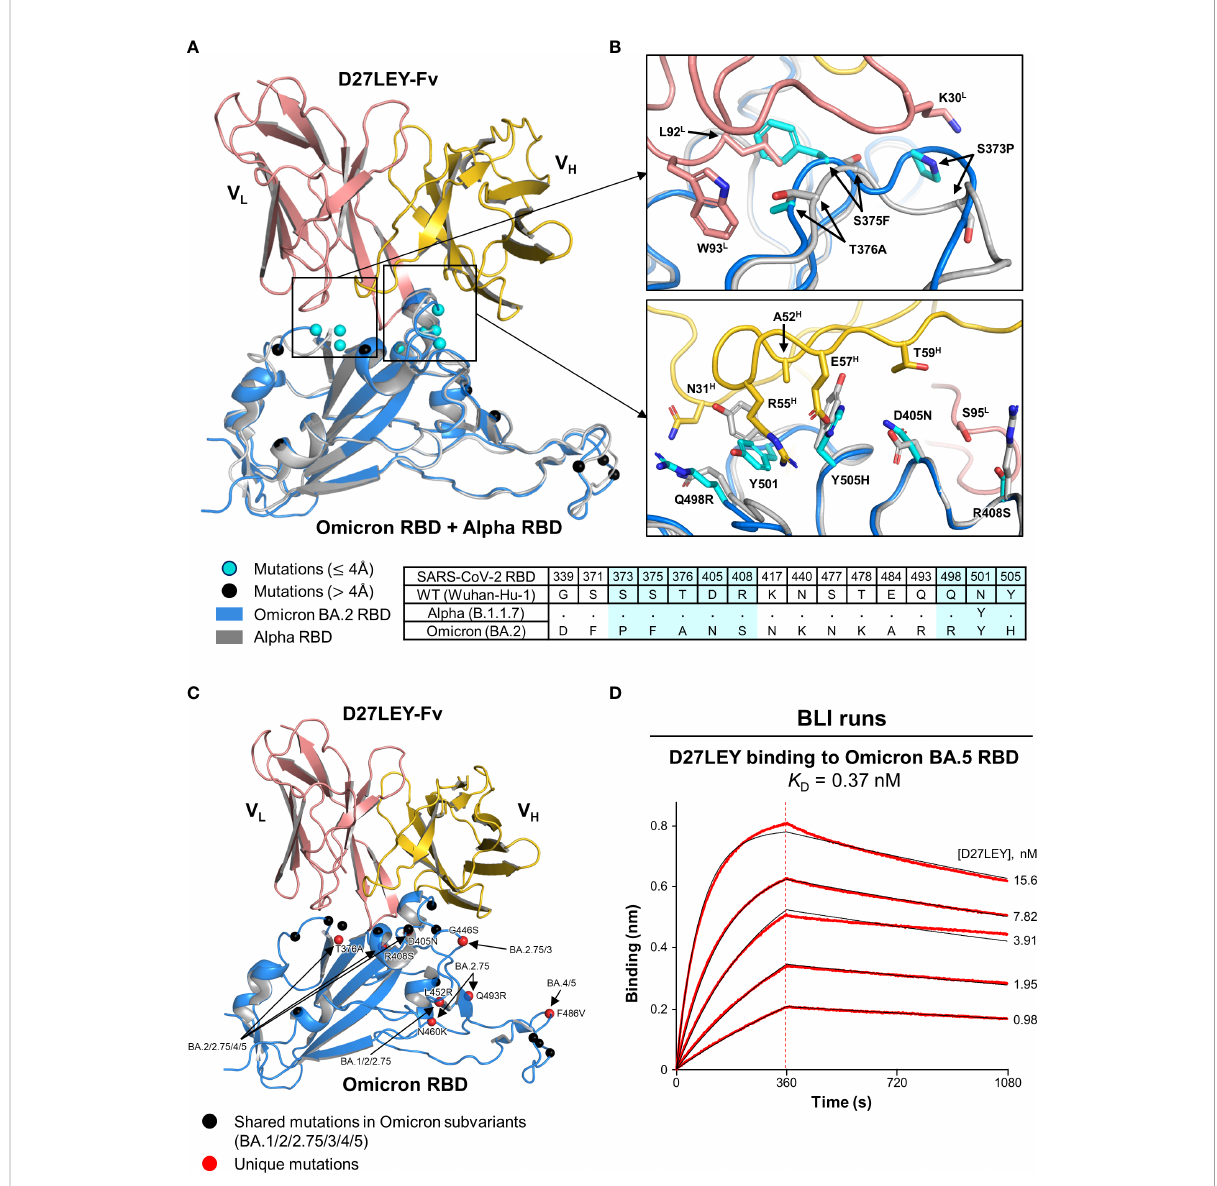
FIGURE 3 A structural model for D27LEY binding to the Omicron RBD (A) Structural superposition of the Omicron RBD (PDB entry: 7ZF8) and D27LEY- Fab – Alpha RBD. The mutations on the RBD of Omicron BA.2 as compared to the RBD of the Wuhan-Hu-1 strain are shown in circles and color- coded according to the interatomic distances from D27LEY. No steric crash is observed between the backbone atoms of D27LEY and the Omicron RBD. (B) Enlarged views of the eight mutations that are within 4 Å of D27LEY. The Omicron and Alpha RBDs are shown in grey and cyan, respectively. Side-chain — side-chain clashes between some of these residues and D27LEY are observed, e.g. , between H505 (Omicron) and E75 H (D27LEY). The amino acid sequences of these two and the wild-type RBDs are compared at the bottom with the eight mutations shaded in cyan. The Alpha RBD differs from the wild-type RBD only at residue 501 in these regions. (C) The mutations on the RBD of the indicated Omicron subvariants are shown in circles and color-coded. None of the subvariant-speci fi c mutations is located on the D27LEY- binding surface. (D) The binding af fi nity of D27LEY for Omicron BA.5 was measured by BLI, and the K D value is